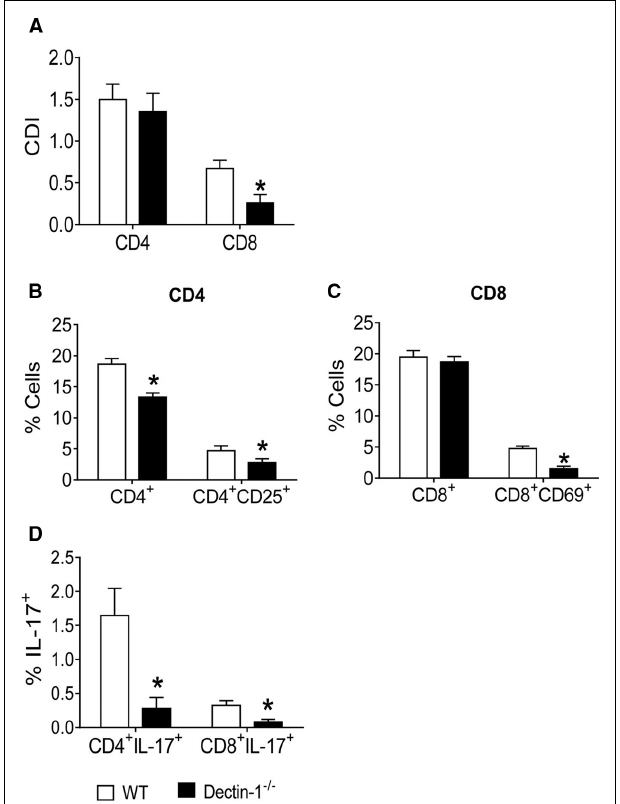
FIGURE 4 | Influence of Dectin-1 receptor in the lymphocyte proliferation, activation and development of IL-17 producing T cells. BMDCs from WT and Dectin-1 (cid:0) / (cid:0) C57BL/6 mice were cultured as described and then infected with viable P. brasiliensis yeasts for 2 h. Splenic lymphocytes from uninfected WT and Dectin-1 (cid:0) / (cid:0) mice were previously labeled with CFSE (5 mM) and co-cultivated with DCs. After 5 days, the cells were adjusted to 1 (cid:2) 10 6 , labeled with specific anti-CD4, CD8, CD25, and CD69 antibodies and analyzed by flow cytometry. (A) Proliferative response of CD4 + and CD8 + T cells. (B,C) The leukocyte population was gated by FSC/SSC analysis and gated cells were analyzed for CD4 + CD25 + (B) and CD8 + CD69 + (C) expression. Some cultures were re-stimulated with PMA/ionomycin for 6 h and subjected to intracellular staining for IL-17. The results are expressed as frequency of IL-17-positive cells (D) . Data are means (cid:6) SD of five wells per group from three independent experiments (* P < 0.05).